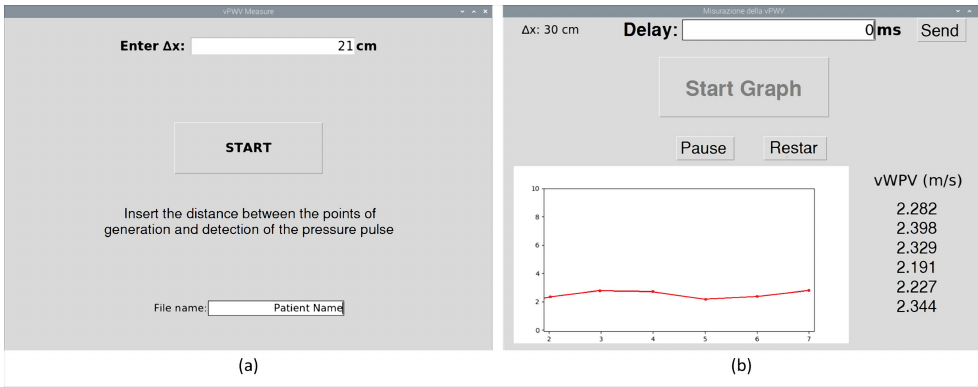
Figure 4. Graphical user interface. ( a ) GUI’s first page allows to enter the preliminary information, such as the distance between the cuff and the ultrasound probe ( ∆ x ), and the name for saving the data. ( b ) In working mode, the GUI displays numerical and graphical representation of measured vPWV values, and allows to adjust the additional delay for the delivery of the the compressive